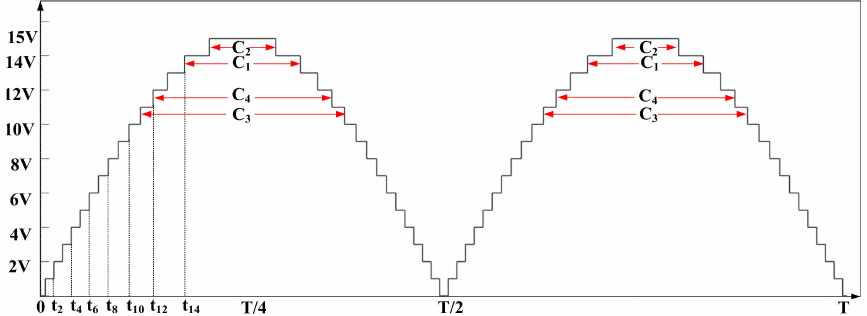
Figure 6. Thirty-one leVel output Voltage waVeforms (inVerted negatiVe cycle) with LDT for different